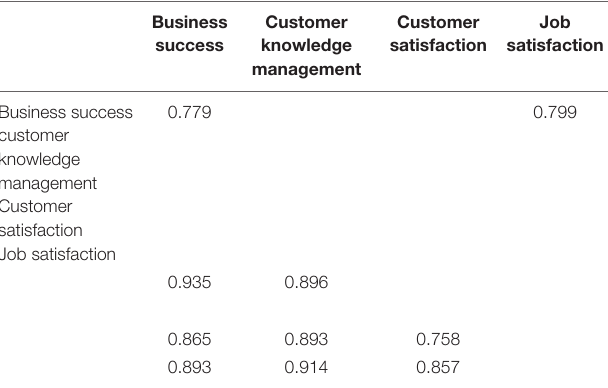
TABLE 3 | Discriminant validity results (HTMT inference